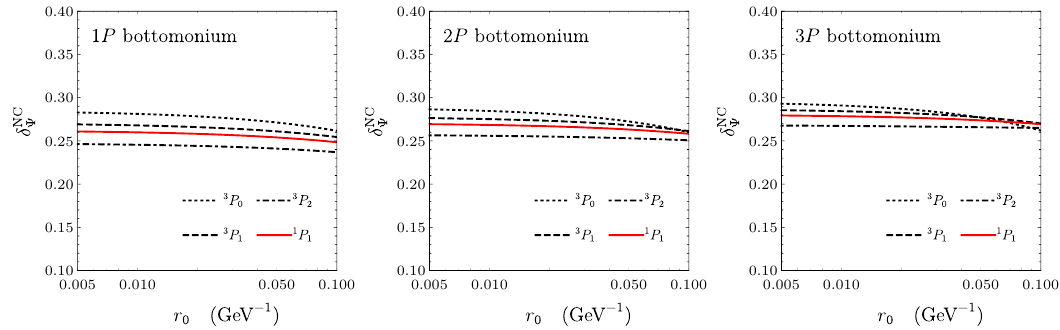
Figure 3 . Non-Coulombic corrections δ NC at finite r 0 for the bottomonium 1 P (left panel), 2 P Ψ (middle panel), and 3 P (right panel) states, for angular momentum quantum numbers 3 P 0 (dotted lines), 3 P 1 (dashed lines), 3 P 2 (dot-dashed lines), and 1 P 1 (red solid lines). The r 0 dependences are mild for the range r 0 < 0 . 02 GeV − 1 that we